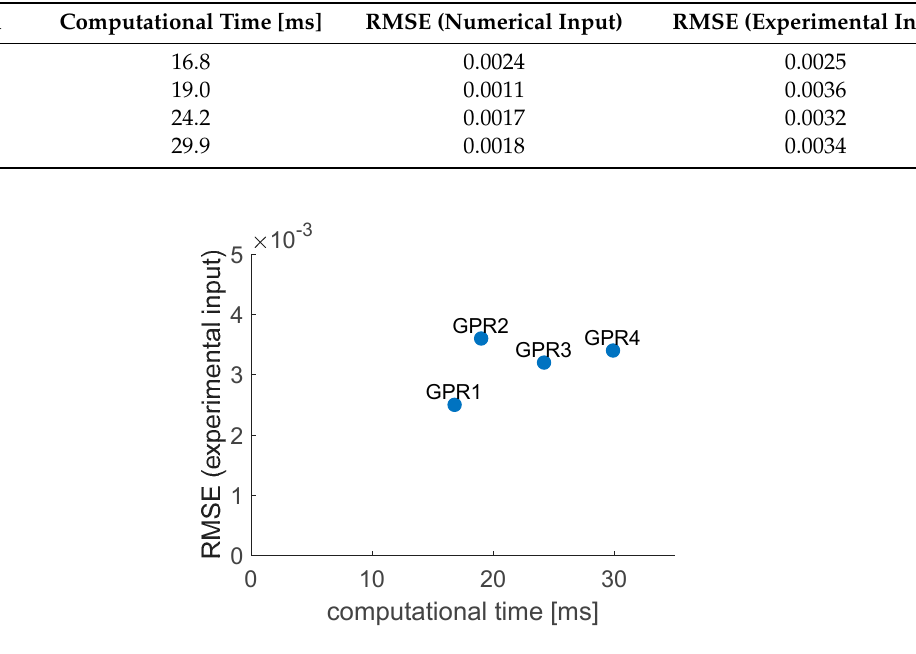
Figure 12. Graphical comparison of accuracy and computational time for obtained GPR models.